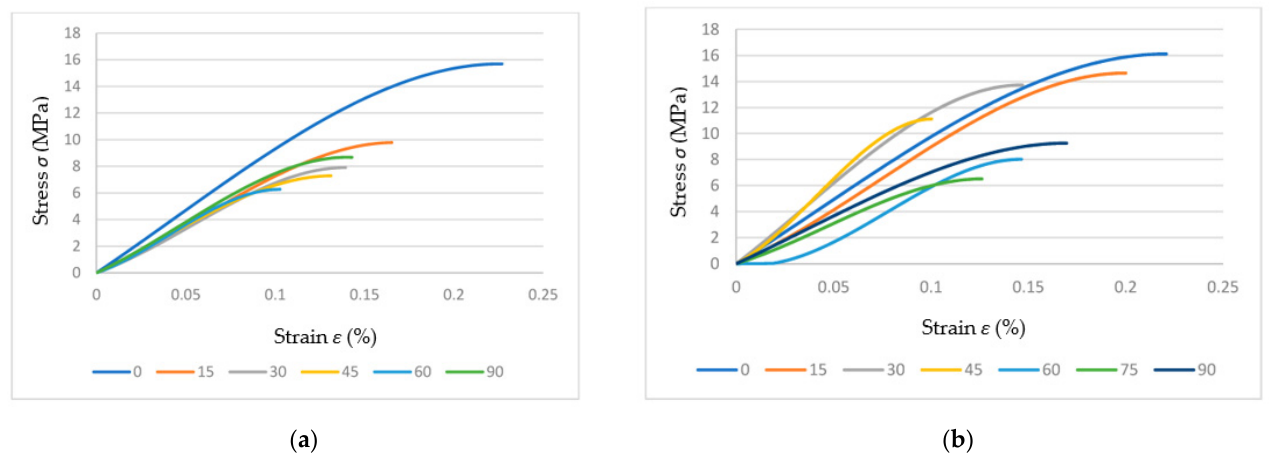
Figure 24. Stress–strain curves for ( a ) flat samples and ( b ) on-edge samples [160]. FEA results showed that honeycomb and lattice patterns were the strongest among the other patterns, while they had lower weight [160]. Martin et al. [161] investigated